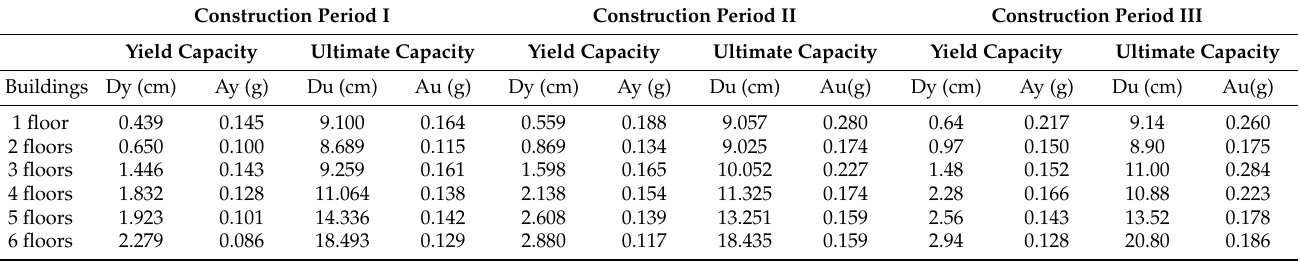
Table A2. Yield and ultimate capacity for buildings without seismic code.